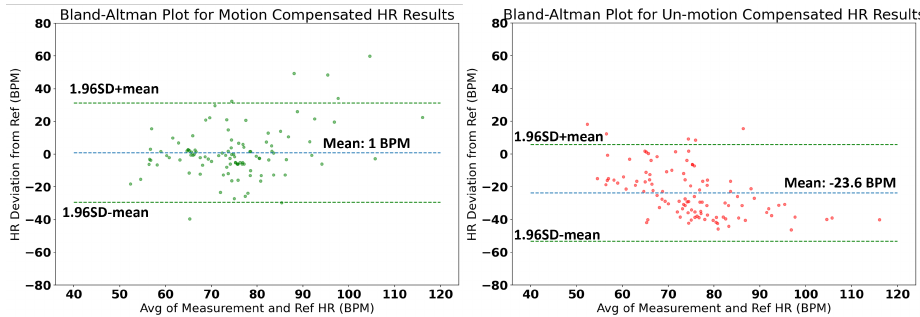
Figure 18. Bland–Altman plot of HR measurements when participants drive on a local road with motion compensation ( left ) and without motion compensation ( right